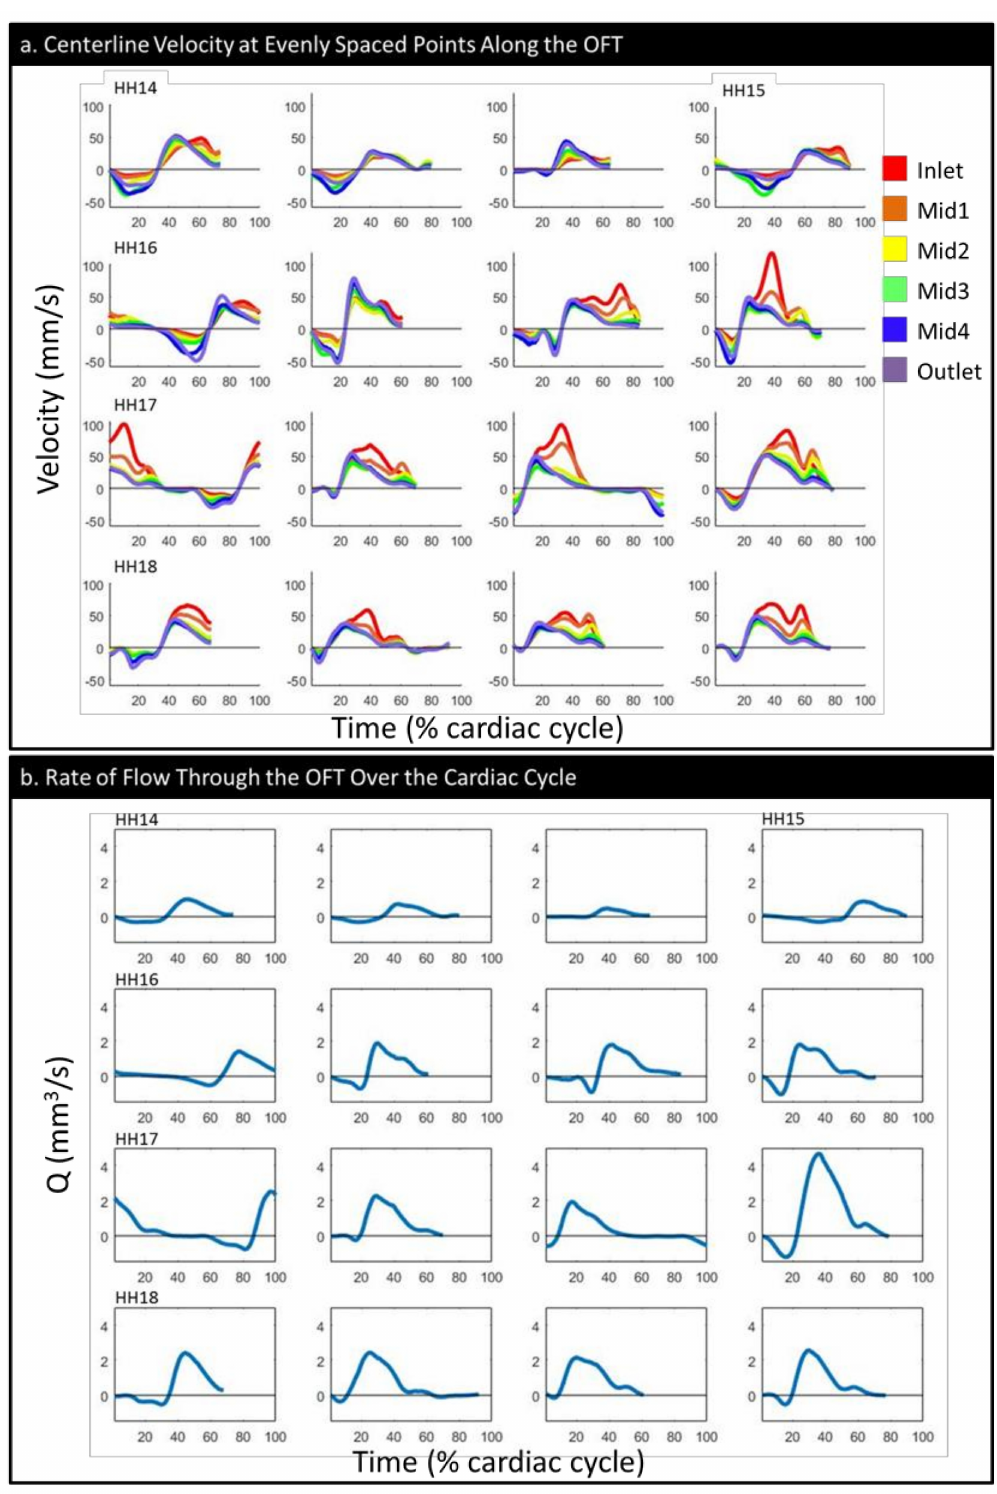
Figure 6. The flow parameters over the simulated portion of the normalized cardiac cycle: ( a ) the velocity magnitude at evenly spaced points along the centerline and ( b ) the flow rate (Q). The embryos have been ordered from youngest to oldest within each stage group and aligned in rows by